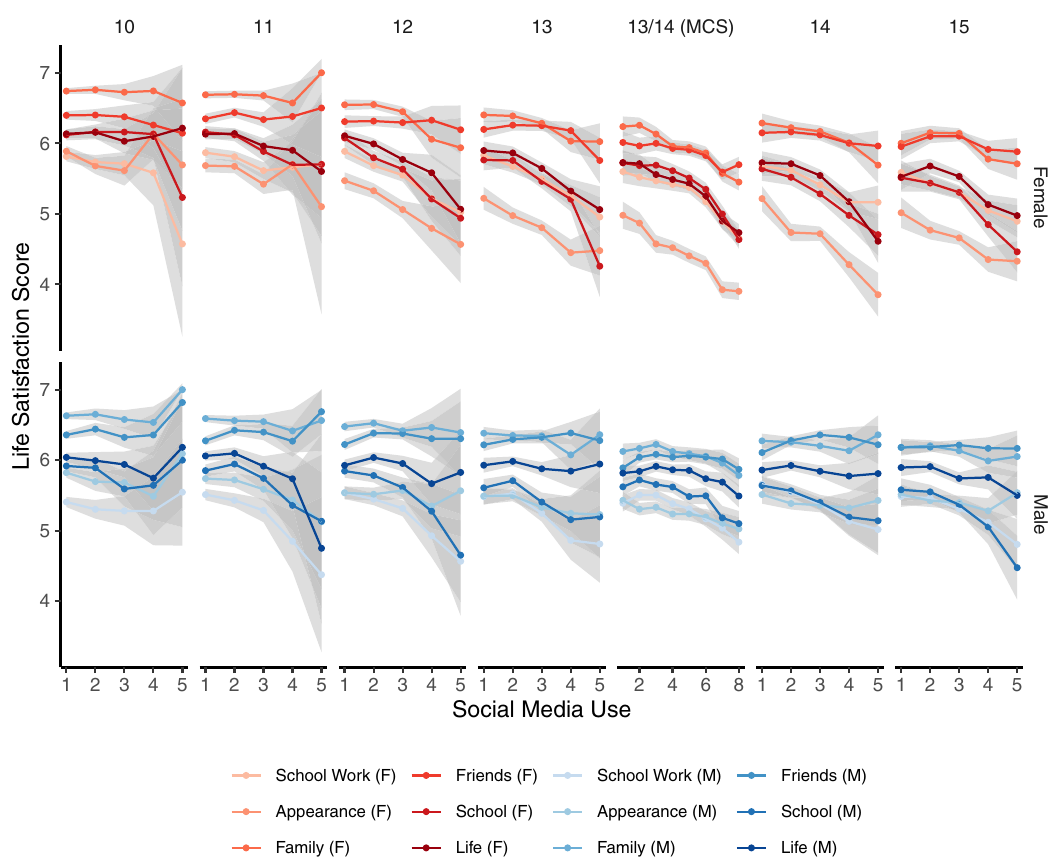
Fig. 2 The cross-section relationship between social media use and six different life satisfaction measurements (ages 10 – 15). The Figure shows the cross-sectional relation between estimated social media use and six life satisfaction measures at ages 10 – 15 (Understanding Society dataset, US; 10,019 participants and 24,698 measurement occasions) and ages 13 – 14 (Millennium Cohort Study dataset, MCS; 11,724 participants). Speci fi cally, it displays the cross-sectional correlation between estimated social media use and raw scores of sub-components of life satisfaction (satisfaction with school work, appearance, family, friends, school, and life). The relationships are presented separately for males and females. The 95% con fi dence intervals represent the lower and upper Gaussian con fi dence limits around the mean based on the t-distribution. Source data for this fi gure are provided as a Source Data fi